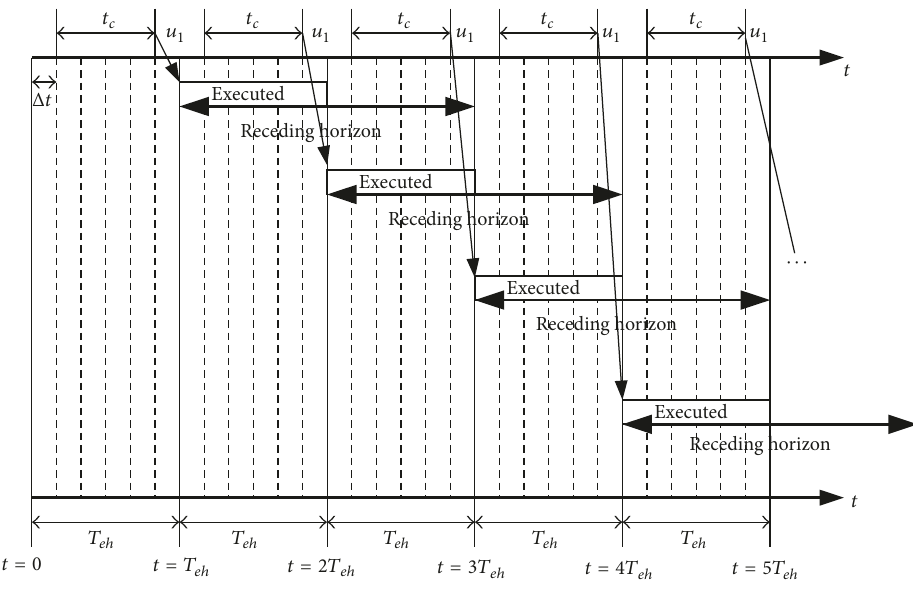
Figure 2: Receding horizon control